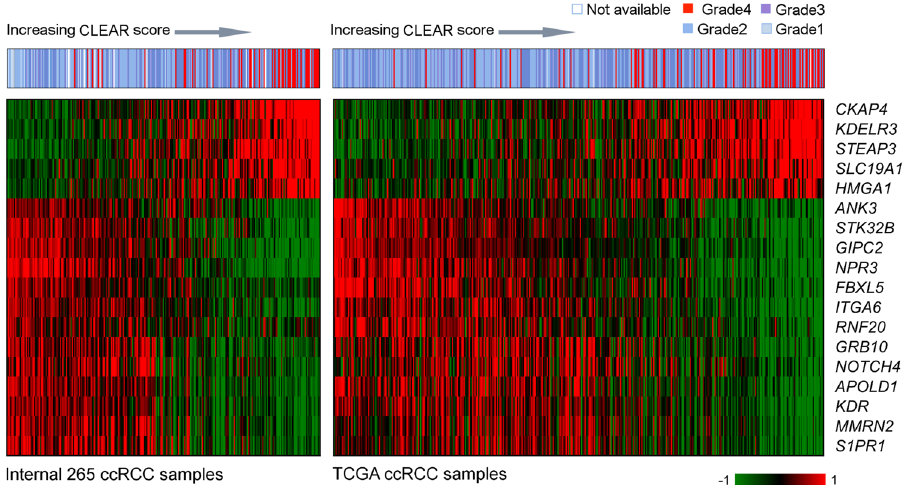
Figure 2. Heatmaps of 18-transcript signature profiles from internal TCGA cohort. The top panel color bar represents the tumor grade distribution profile as determined by the 18-transcript signature. Heatmaps below the color bar are gene expression profiles from cohorts of internal 265 samples and 414 TCGA ccRCC samples. Samples are ranked in ascending order based on CLEAR score. We observe that signature genes show a consistent expression pattern in these two cohorts. A similar association between CLEAR score and tumor grade was